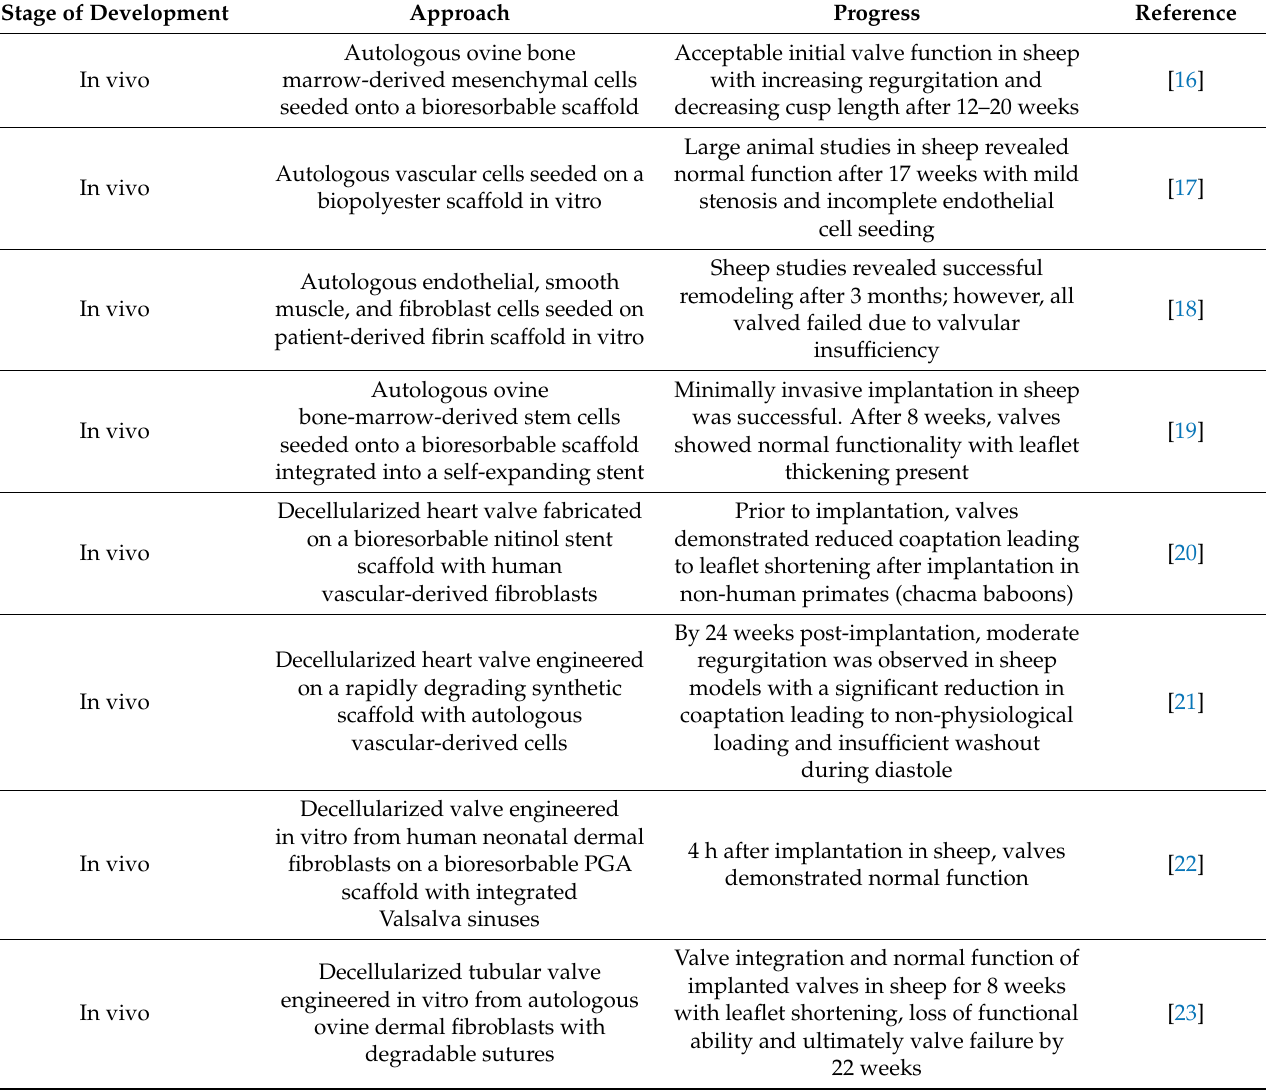
Table 1. Overview of recent preclinical and clinical evaluation of growing heart